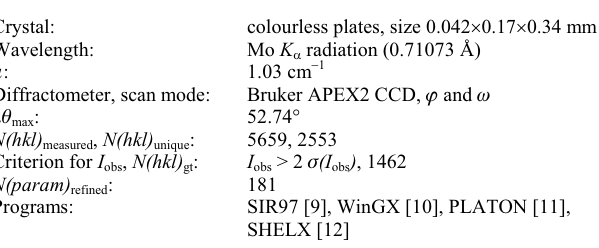
Table 1. Data collection and handling.